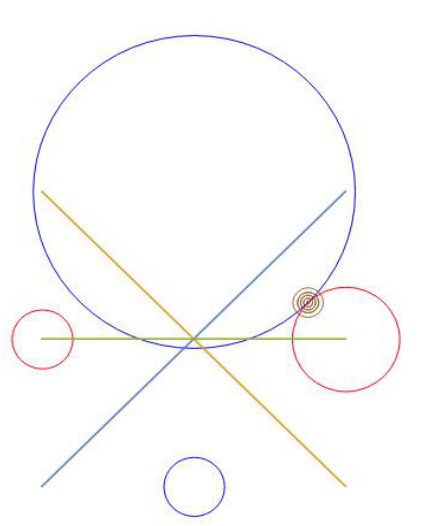
Figure 2. Representation of the distances to the nearest points of the point ( 3/4,1/4 ) : according